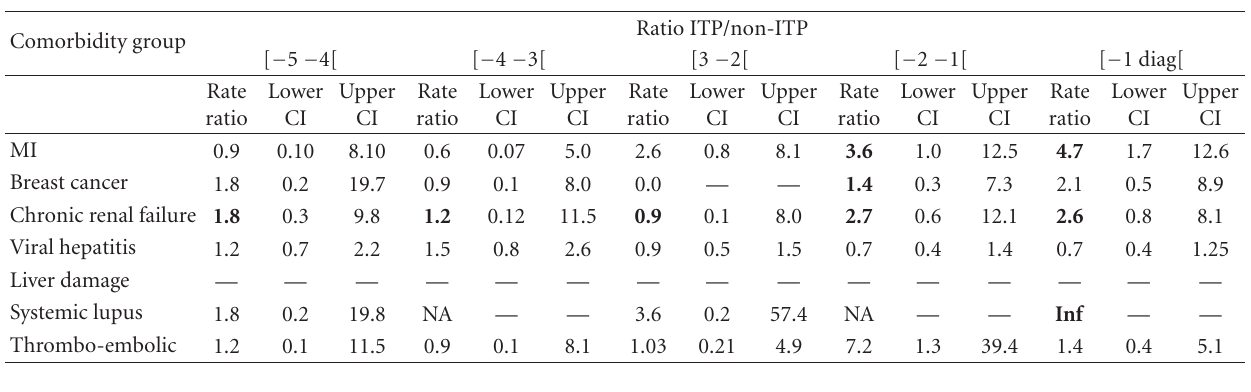
Table 6: Yearly incidence rates ratios between ITP and non-ITP and their 95% confidence interval of 7 comorbidities of priori interest. Comorbidity